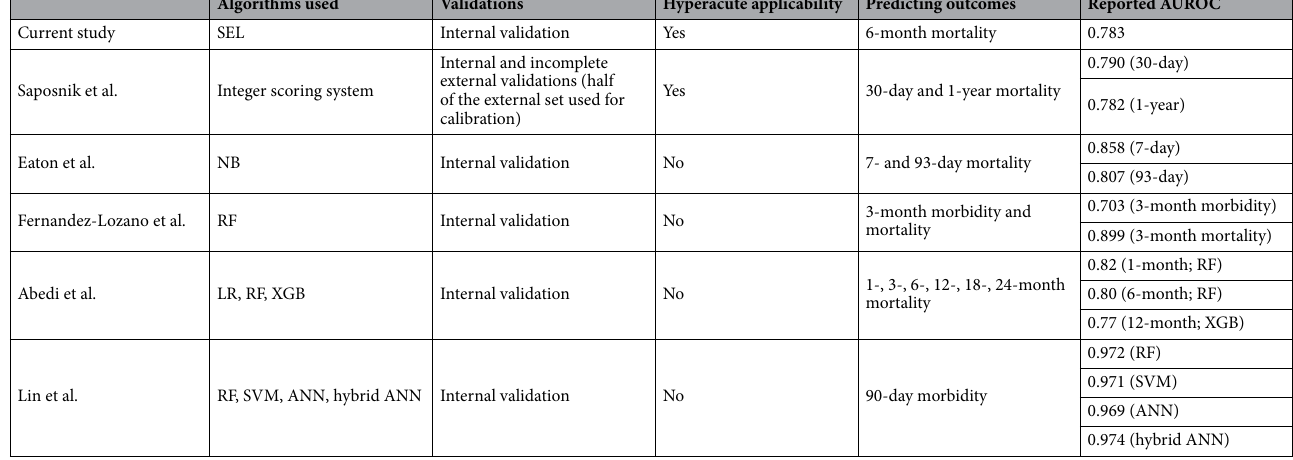
Table 3. Comparison of selected mortality prediction models for AIS patients. Hyperacute applicability means all selected features are assessable at the time of initial